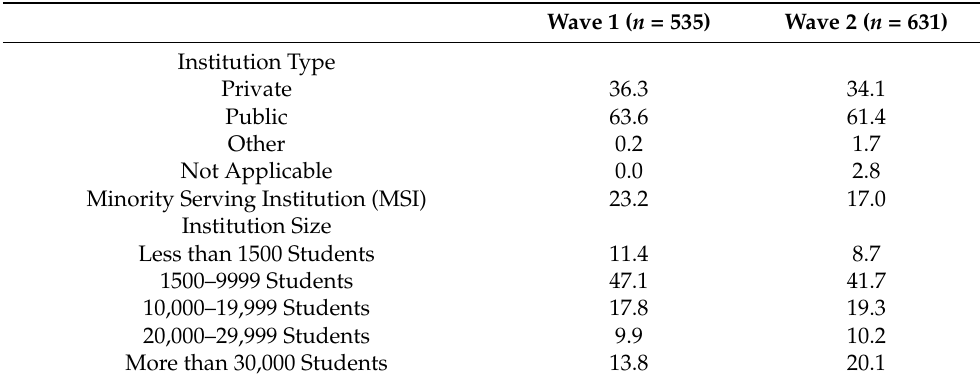
Table 1. Institutional profile of survey participants, by